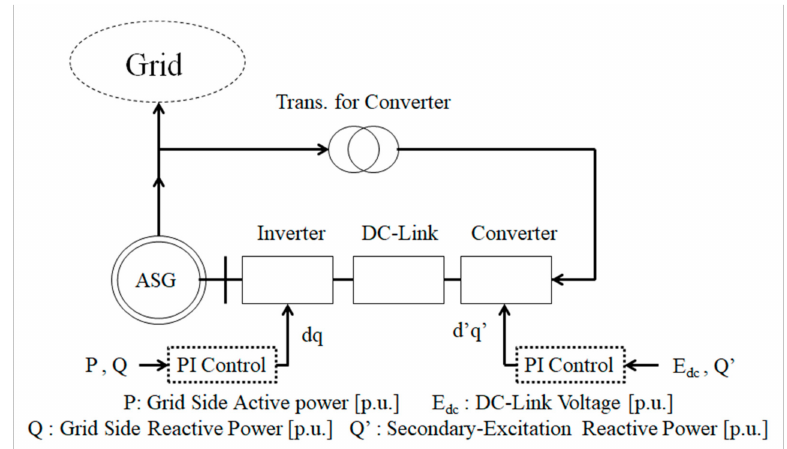
Figure 6. Adjustable-speed pumping generator (ASG) configuration.